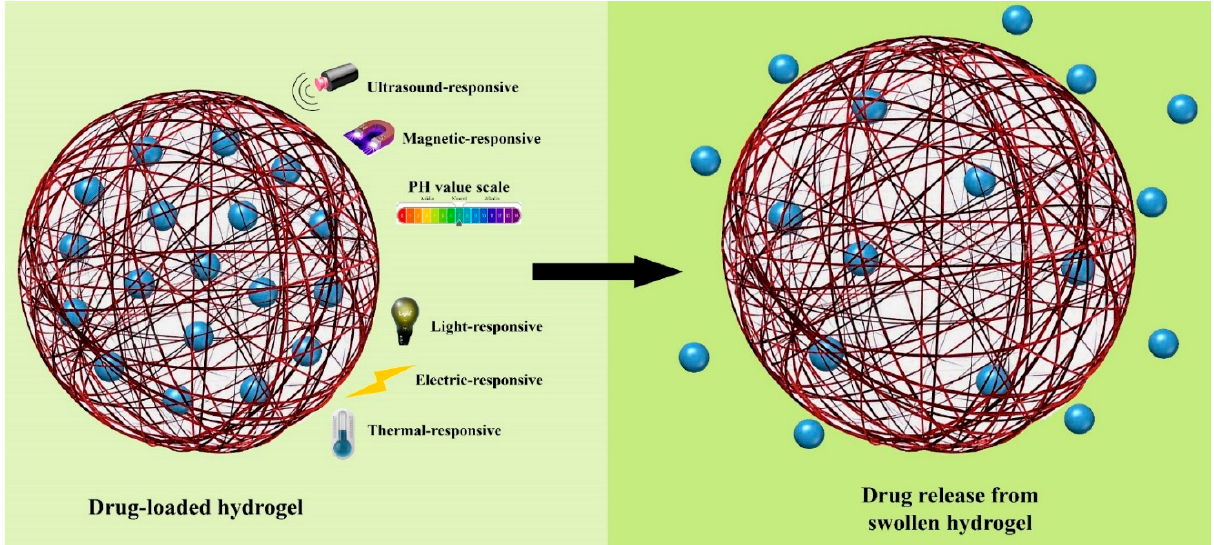
Figure 6. Parameters that have an effect on the properties of smart hydrogels. Photoshop 2020 was used to create this figure.